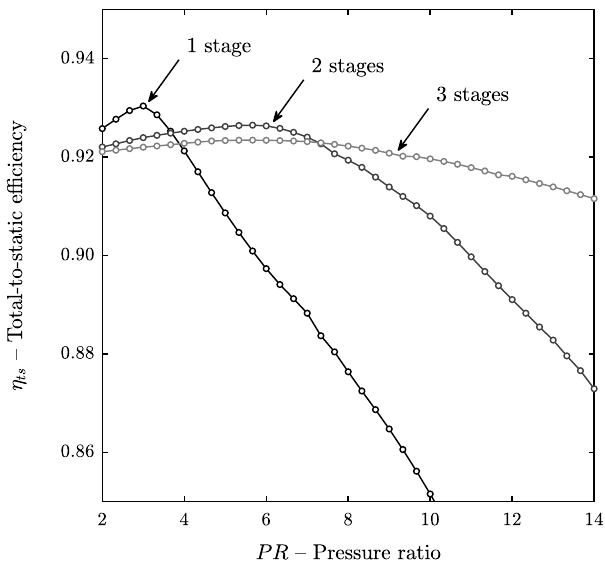
Figure 6. Influence of the pressure ratio and number of